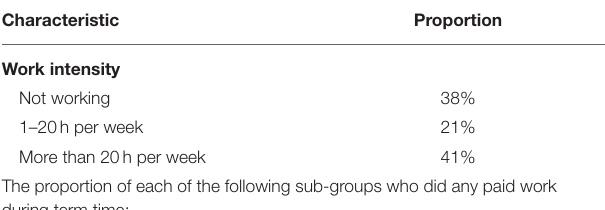
TABLE 1 | Undergraduate student work during term